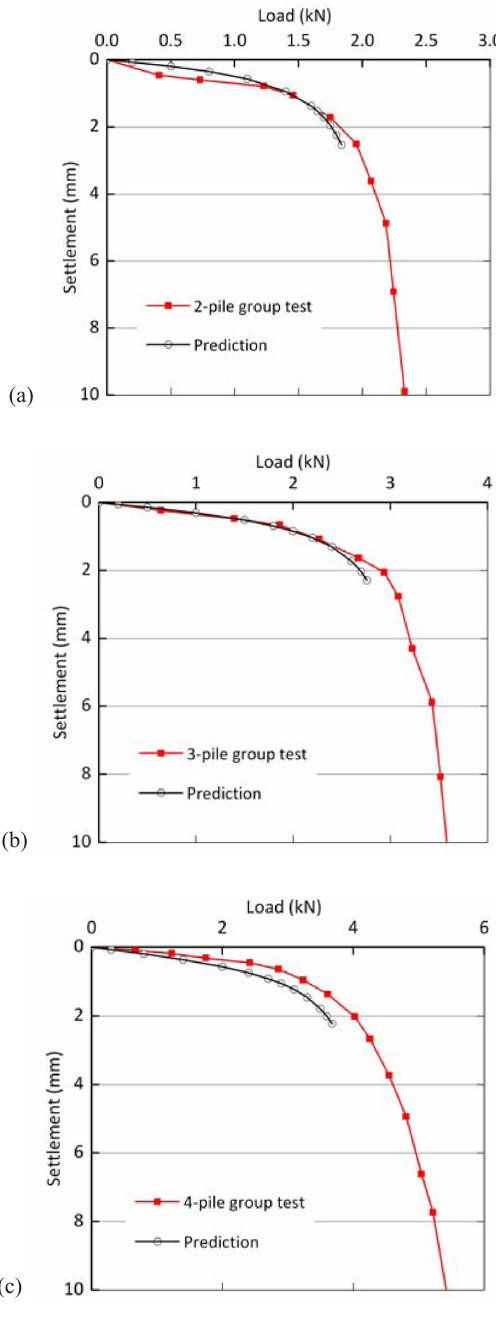
Fig. 14. Comparison of measured and predicted pile group response in loose sand ( S/B = 3): (a) 2-pile group; (b) 3-pile group; (c) 4-pile